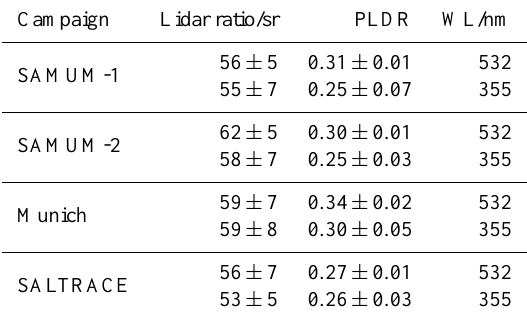
Table 2. Mean values and mean systematic errors of the lidar ratio and the linear particle depolarization ratio of Saharan dust at 355nm and 532nm derived for fresh Saharan dust during SAMUM-1 in Ouarzazate, Morocco, in 2006 (Tesche et al., 2009b); for mid-range transported Saharan dust during SAMUM-2 in Cape Verde in 2008 (Groß et al., 2011b); for long-range transported dust over Central Europe in Munich, Germany, in 2008 (Wiegner et al., 2011); and for long-range transported Saharan dust over the Caribbean during SALTRACE in Barbados in